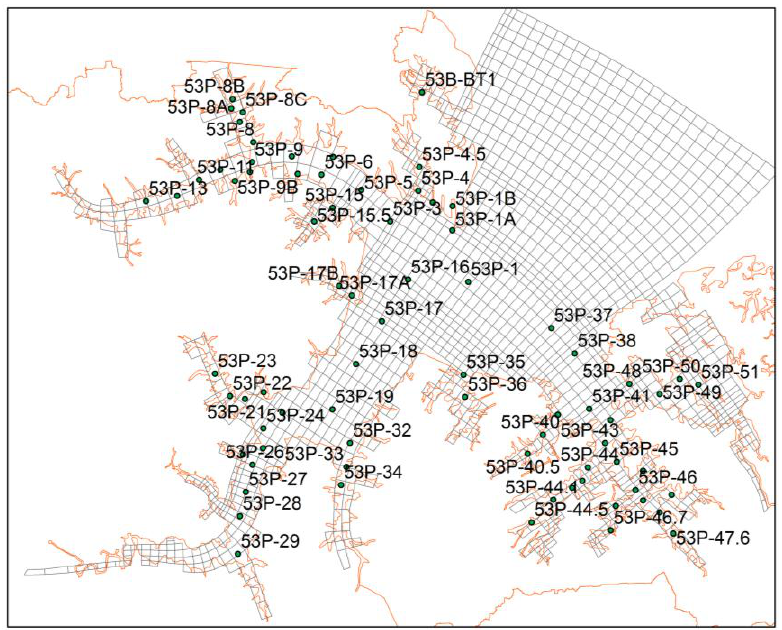
Figure 4. Locations of observation stations and the EFDC numerical model grid .